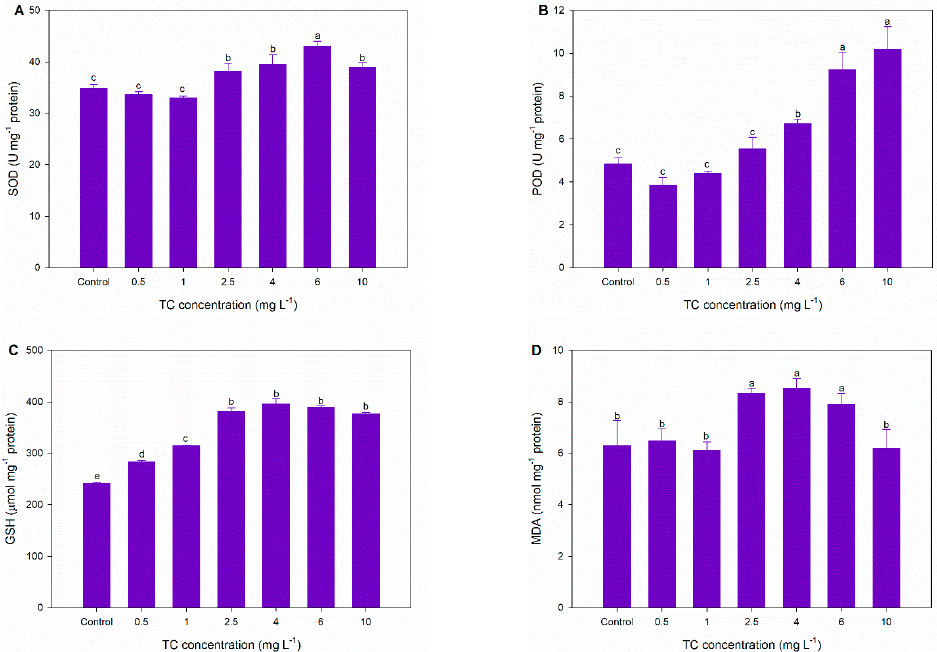
Figure 4. Changes in the activities of SOD ( A ) and POD ( B ), and the levels of GSH ( C ) and MDA ( D ) of C. pyrenoidosa after 48 and 96 h of exposure in different treatments. The different letters indicate significant differences ( p < 0.05) between the control and experimental treatments.